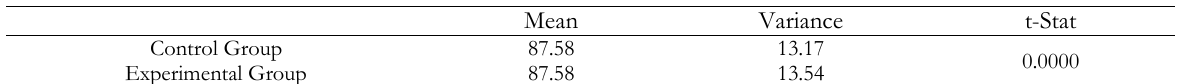
Table 1. Result of equivalency